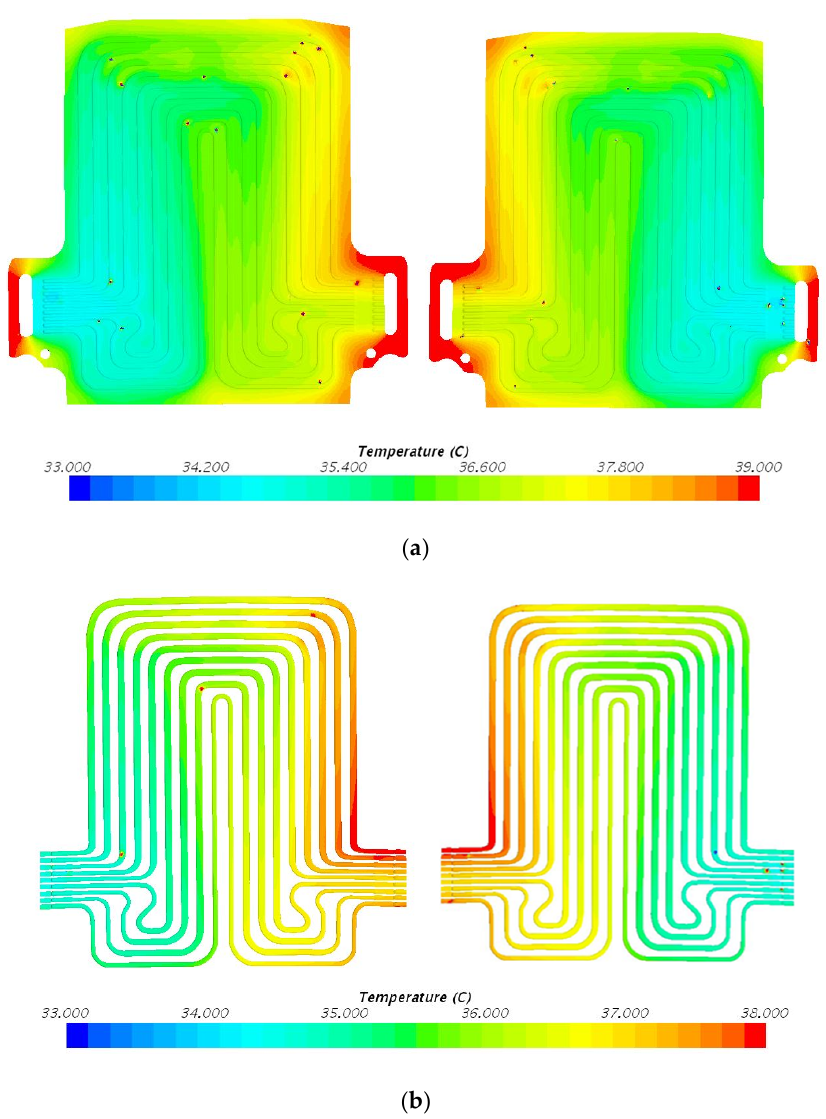
Figure 10. Temperature profile at 60 A and 35 °C with heat flux values near cathode = 1468.4 W/m 2 , = 1579.9 W / m 2 , and mid surface = 340.6 W / m 2 . ( a ) Top view and ( b ) bottom anode = 1579.9 W/m 2 , and mid surface = 340.6 W/m 2 . (a) Top view and (b) bottom view. anode